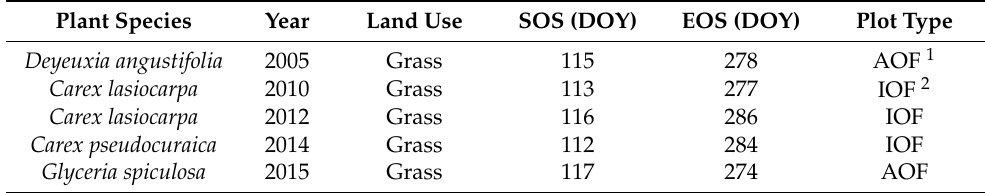
Table 2. In situ phenological period data set from the Sanjiang Observation Station. Plant Species Year Land Use SOS (DOY) EOS (DOY) Plot